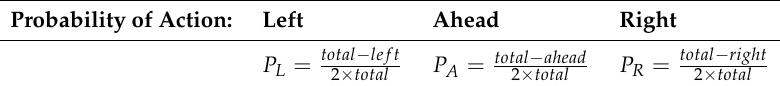
Table 1. Pheromone action